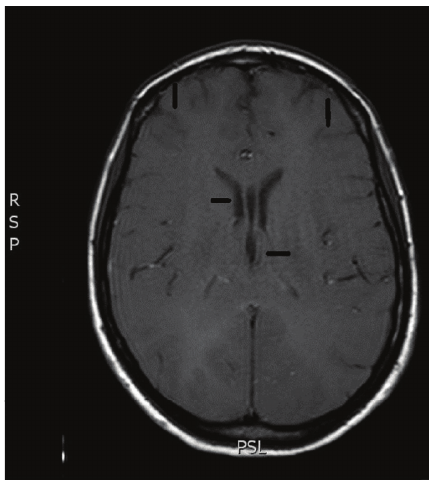
Figure 2: Brain MRI (T1-weighted image) was repeated and showed marked decrease in the volume of cerebral edema following 10 days of therapy with prednisone. Note the increased space of the gray- white matter junction and the ventricles